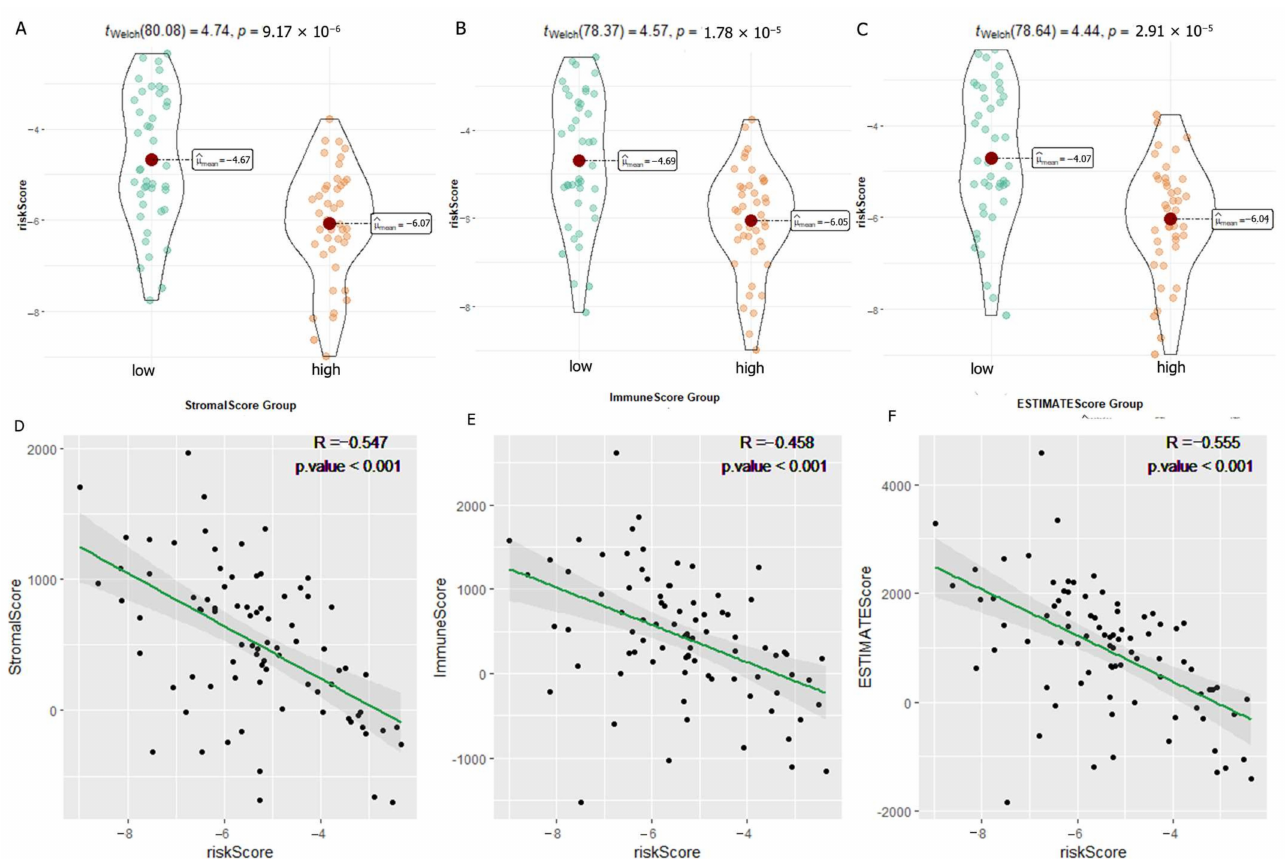
Figure 14. Correlation analysis of immune-related scores and risk scores. ( A – C ) Analysis of the variability of risk scores among different StromalScore ( A ), ImmuneScore ( B ), and ESTIMATEScore ( C ) subgroups. ( D – F ) Scatter plots of correlations between risk scores and StromalScore ( D ), Im- muneScore ( E ), and ESTIMATEScore ( F ).